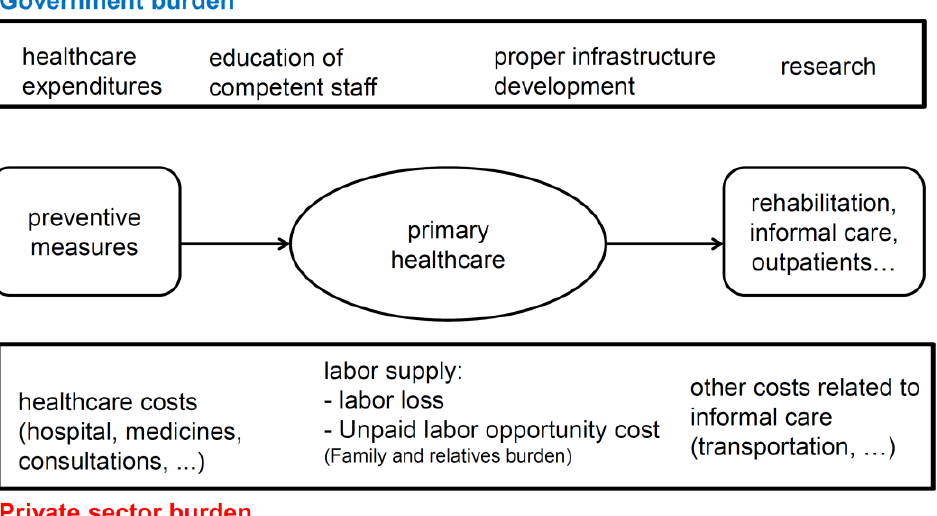
Figure2. Diseaseburdenratesbycancertype, SoutheastAsia, 2016, age-standardizeddisability-adjusted life year (DALY) rates per 100,000 individuals by cancer types. Note: DALYs are used to measure the total burden of disease: both from the years of life lost and years lived with a disability. One DALY Figure 2. Disease burden rates by cancer type, Southeast Asia, 2016, age-standardized disability- adjusted life year (DALY) rates per 100,000 individuals by cancer types.